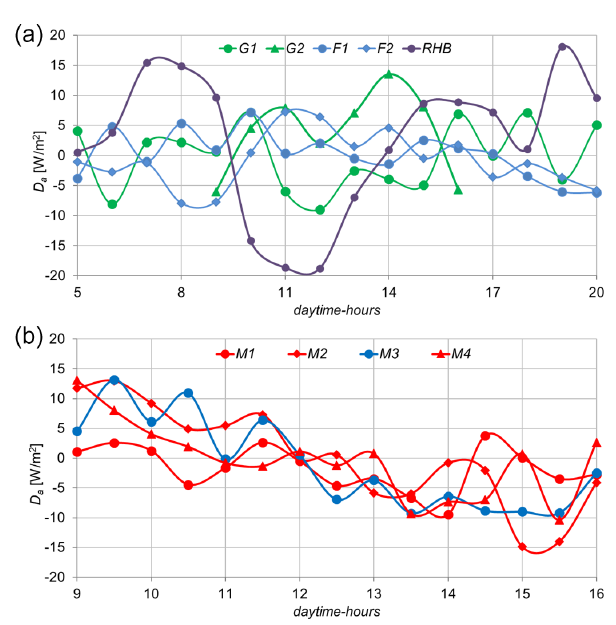
Figure 5. Differences D a = LE LY − LE EC_a : (a) as a function of daytime hours, humid; and (b) as a function of daytime hours, Ma- jadas; red: dry; blue: rainy season.